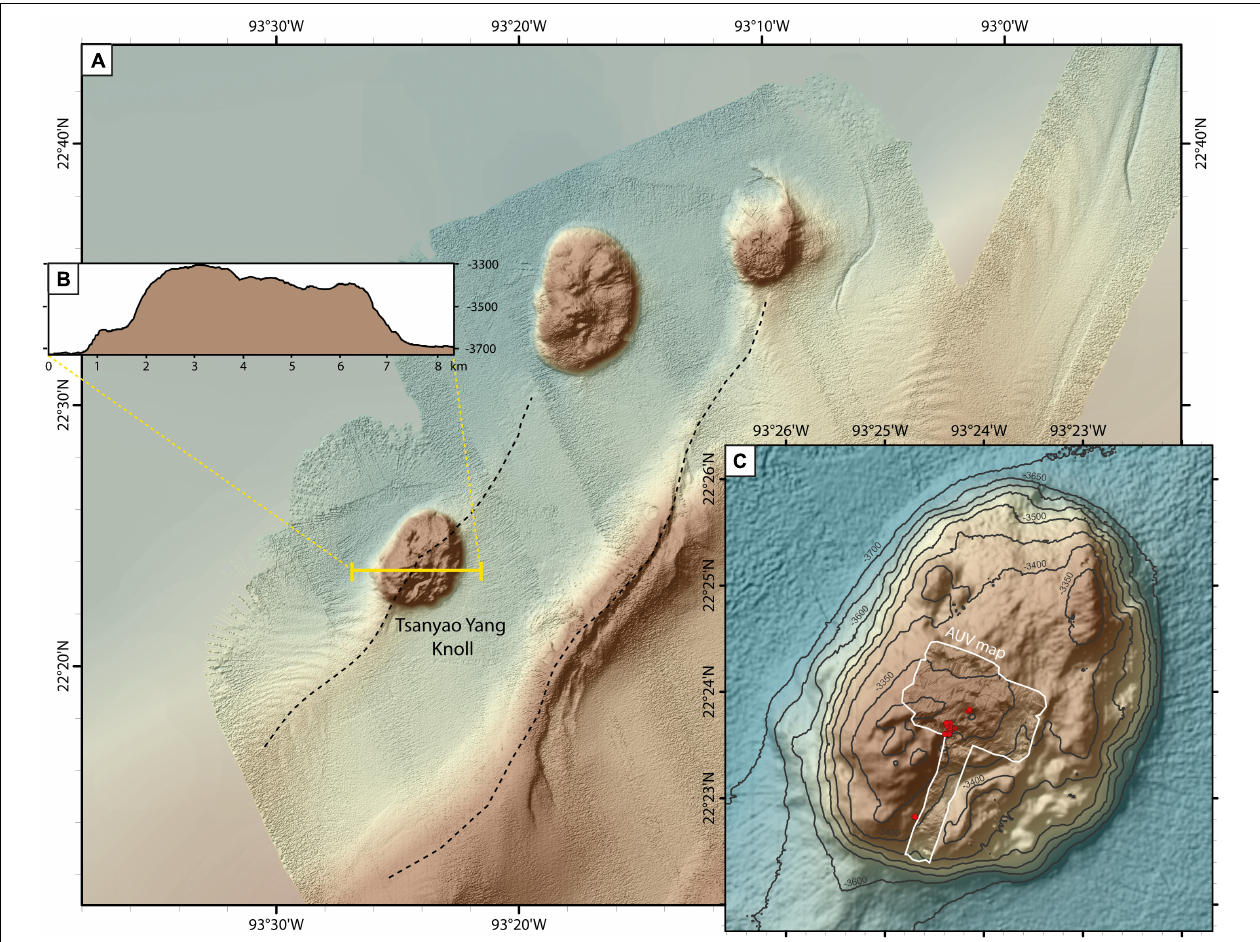
FIGURE 2 | (A) Bathymetric map (from multibeam data acquired during R/V METEOR cruise M114 over GEBCO data) of the northernmost area of the Campeche Knolls including Tsanyao Yang Knoll (TYK) and two unnamed knolls northeast of TYK. Knolls and ridges appear to be SW-NE directed in this area, as highlighted by dashed-lines. (B) Morphological profile crossing TYK in W-E direction illustrating steep flanks and a truncated top. (C) Close-up of the bathymetry at the top of TYK combining ship- and AUV-based (white outline) multibeam data. Red dots indicate vertical seafloor projections of flare locations detected in hydro-acoustic